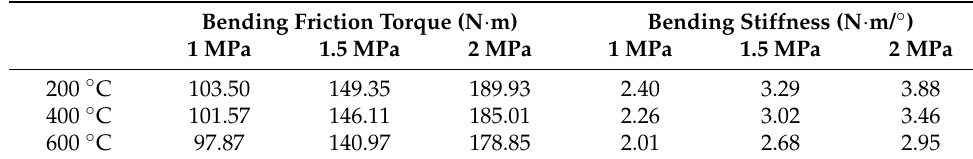
Figure 5. Bending characteristic curves of ball joints under different loads. Table 3. Characteristic parameters of ball joint under different loads.